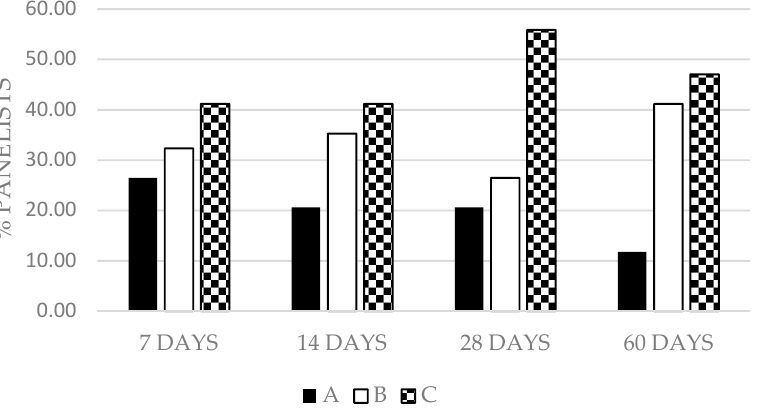
Figure 2. Percentage of panelists who considered a particular group favorite (A: 0.055% w / w ; B: 0.035% w / w ; C: 0.015% w / w ) during the study period (7, 14, 28 and 60 days of storage).